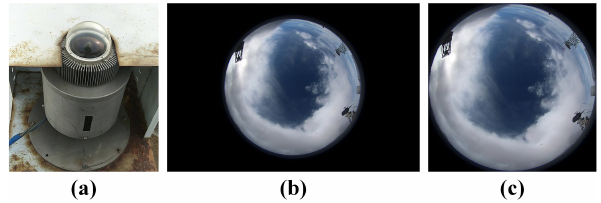
Figure 1. ASI device and ASI image. (a) ASI device including a fish-eye lens, an industrial camera, and a clear glass cover. (b) Orig- inal RGB color ASI image (2592 × 1728 pixels) and (c) resized RGB color ASI image of (b) (1408 × 1408 pixels).